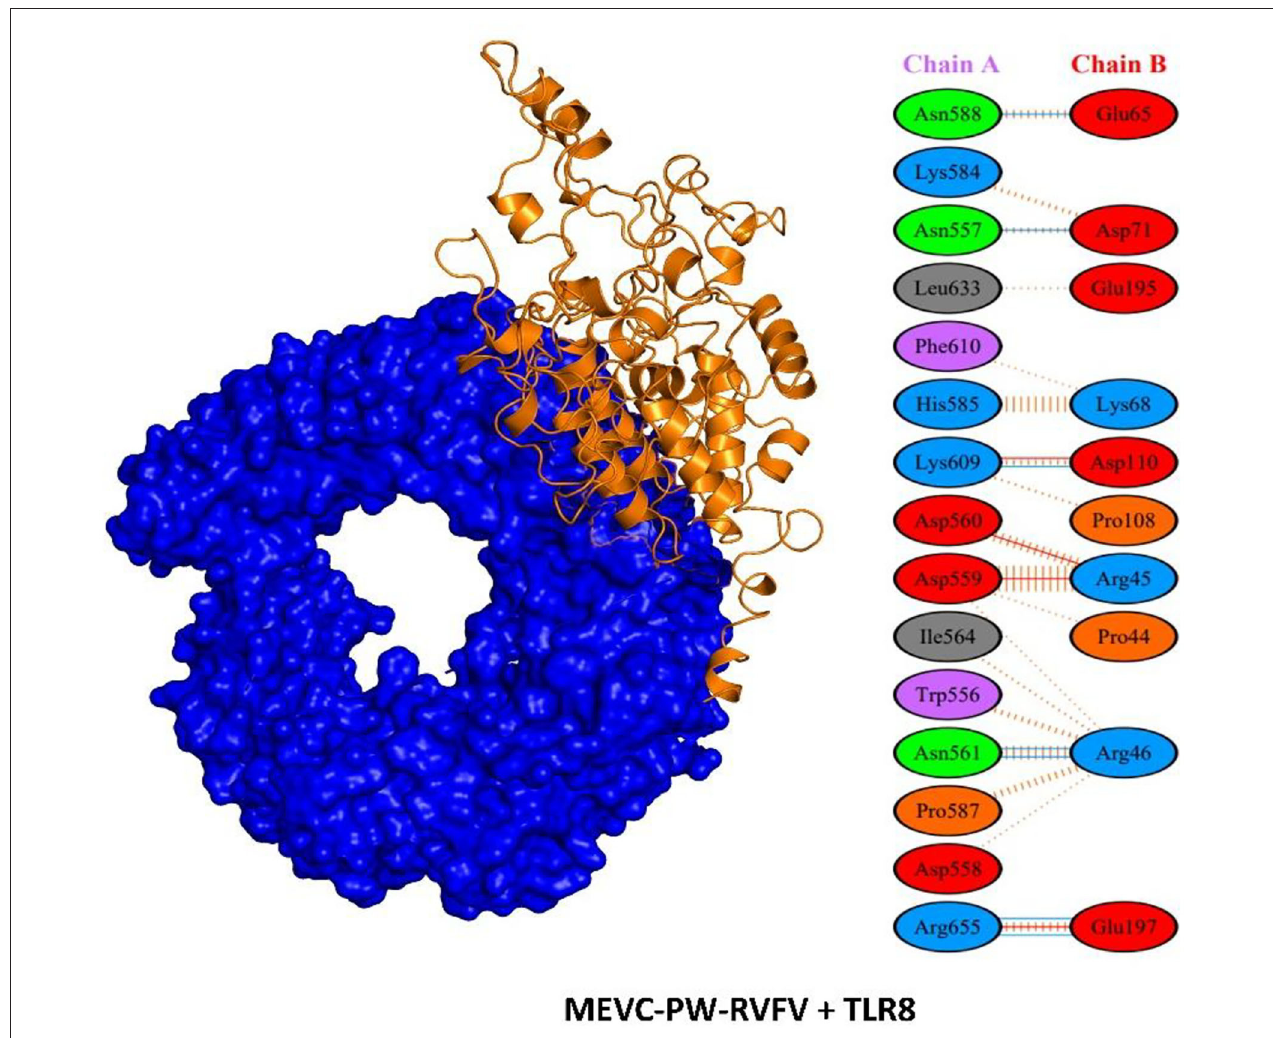
FIGURE 7 | Structural representation of docking complex of MEVC and interaction pattern of the MEVC designed against the whole proteome of RVFV with human